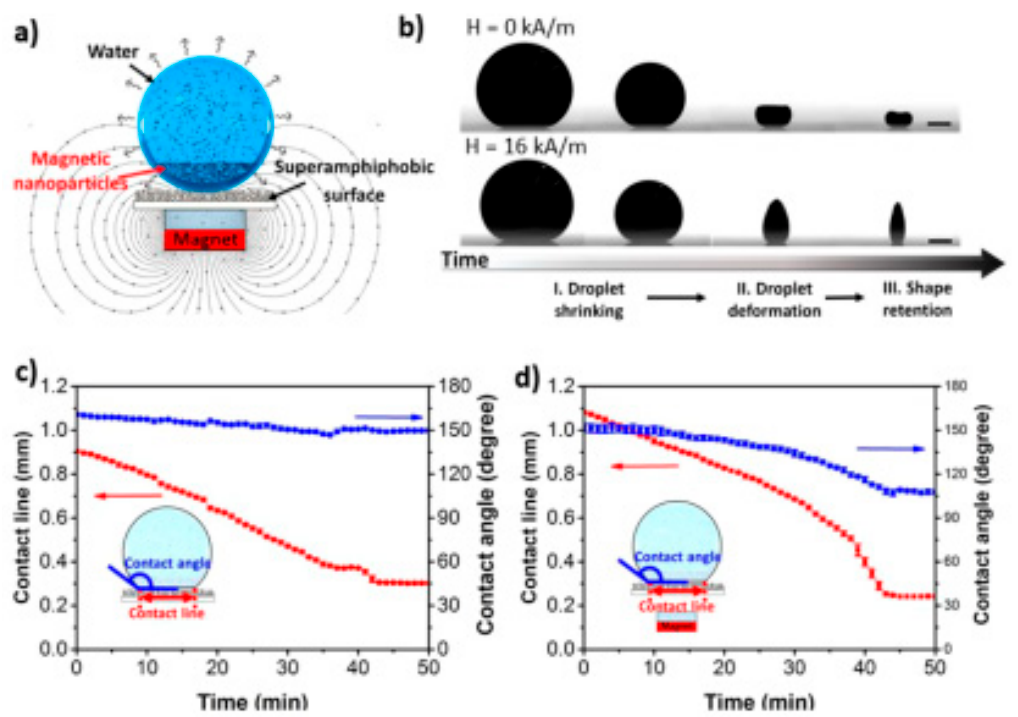
Figure 8. Formation of large 3D superparamagnetic structures by making use of the magnetic properties of ferrofluids. ( a ) Experimental system used for the production of supraparticles by evaporation-guided assembly of a magnetic NPs dispersion on a superamphiphobic surface. ( b ) Evolution of a 3 wt % droplet during drying without (upper panel) and with (bottom panel) magnetic field. Scale bars are 0.5 mm. Drying curve of the droplet ( c ) without and ( d ) with magnetic field. Insets represent the dimensions measured during drying (reprinted with permission from [172]. Copyright